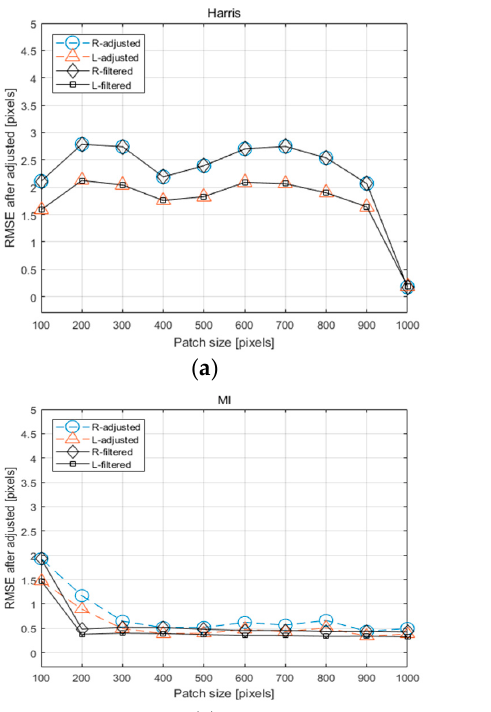
Figure 20. Reprojection errors (across-track Kompsat-3A original—after adjustment): ( a ) HARRIS– FREAK ( b ) SURF, ( c ) MI, and ( d ) PC.